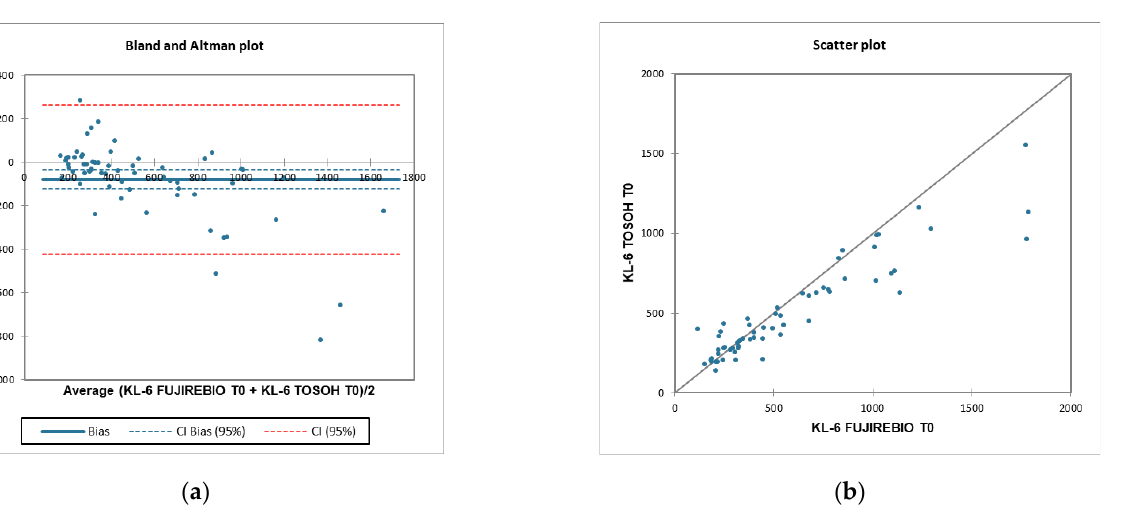
Figure 5. ( a ) Bland–Altman analysis using T0 KL-6 concentrations detected by two methods, CLEIA and FEIA by Lumipulse G600II and AIA360 system, respectively, for assessing agreement and Bias between systems. ( b ) Scatter plot analysis to perform linear correlation between KL-6 T0 Lumipulse G600II and AIA360.